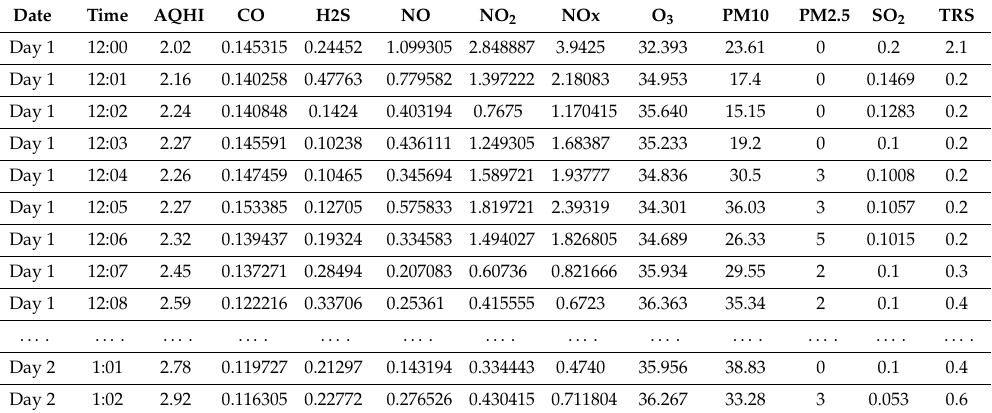
Table 4. Examples from the dataset that describes the outdoor environment.